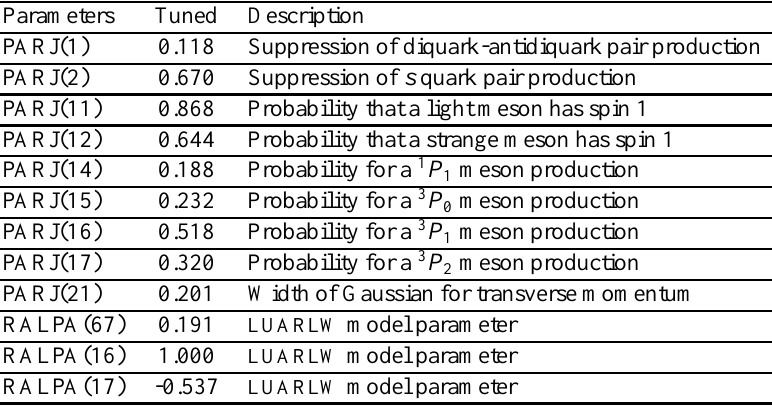
Table 1. Optimized parameters at √ s = 3.08 GeV. The statistical errors are negligible. (2 S + 1) P J denotes a meson has spin S , orbital angular momentum ( L ) and total spin J